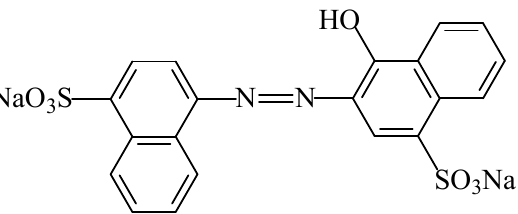
Figure 18. Structural formula of the azorubine food colour (E122).